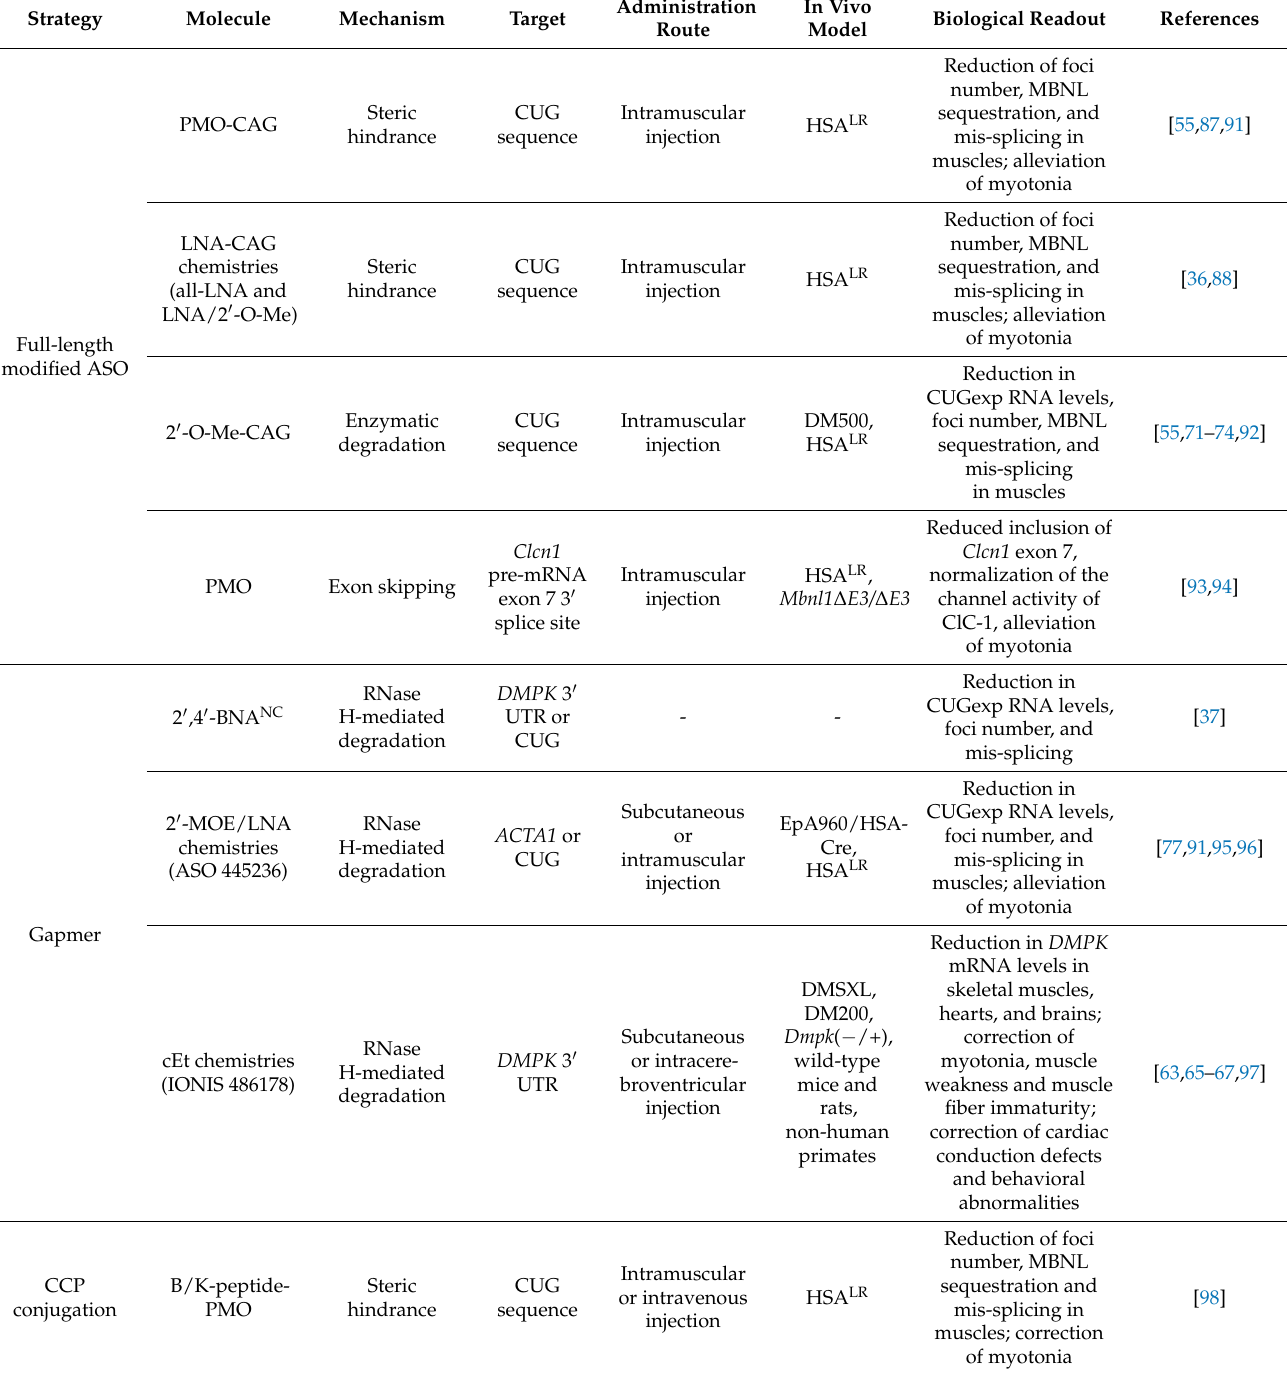
Table 1. Summary of antisense strategies investigated for treating